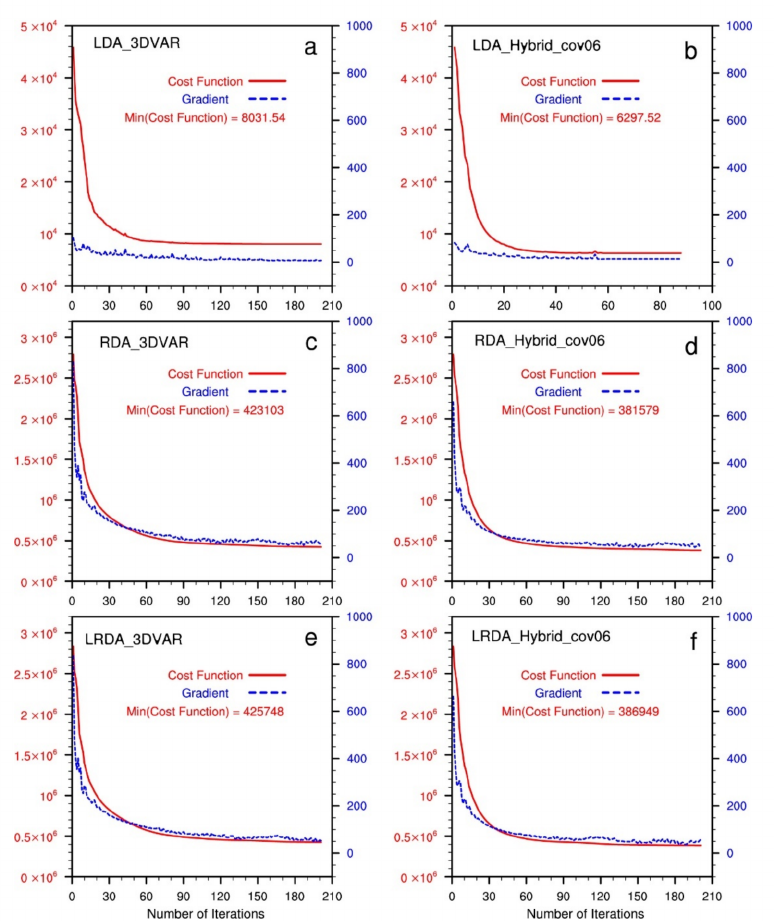
Figure 2. The total cost function and summation of gradient norm as a function of the number of iterations in single-analysis experiments. The red solid line is the cost function (left Y-axis), and the blue dashed line is the gradient norm (right Y-axis). ( a , b ) Lightning data assimilation by 3DVAR (LDA_3DVAR) and hybrid 3DEnVAR (LDA_Hybrid_cov06), ( c , d ) radar data assimilation by 3DVAR (RDA_3DVAR) and hybrid 3DEnVAR (RDA_Hybrid_cov06), and ( e , f ) the combined lightning and radar data assimilation by 3DVAR (LRDA_3DVAR) and hybrid 3DEnVAR